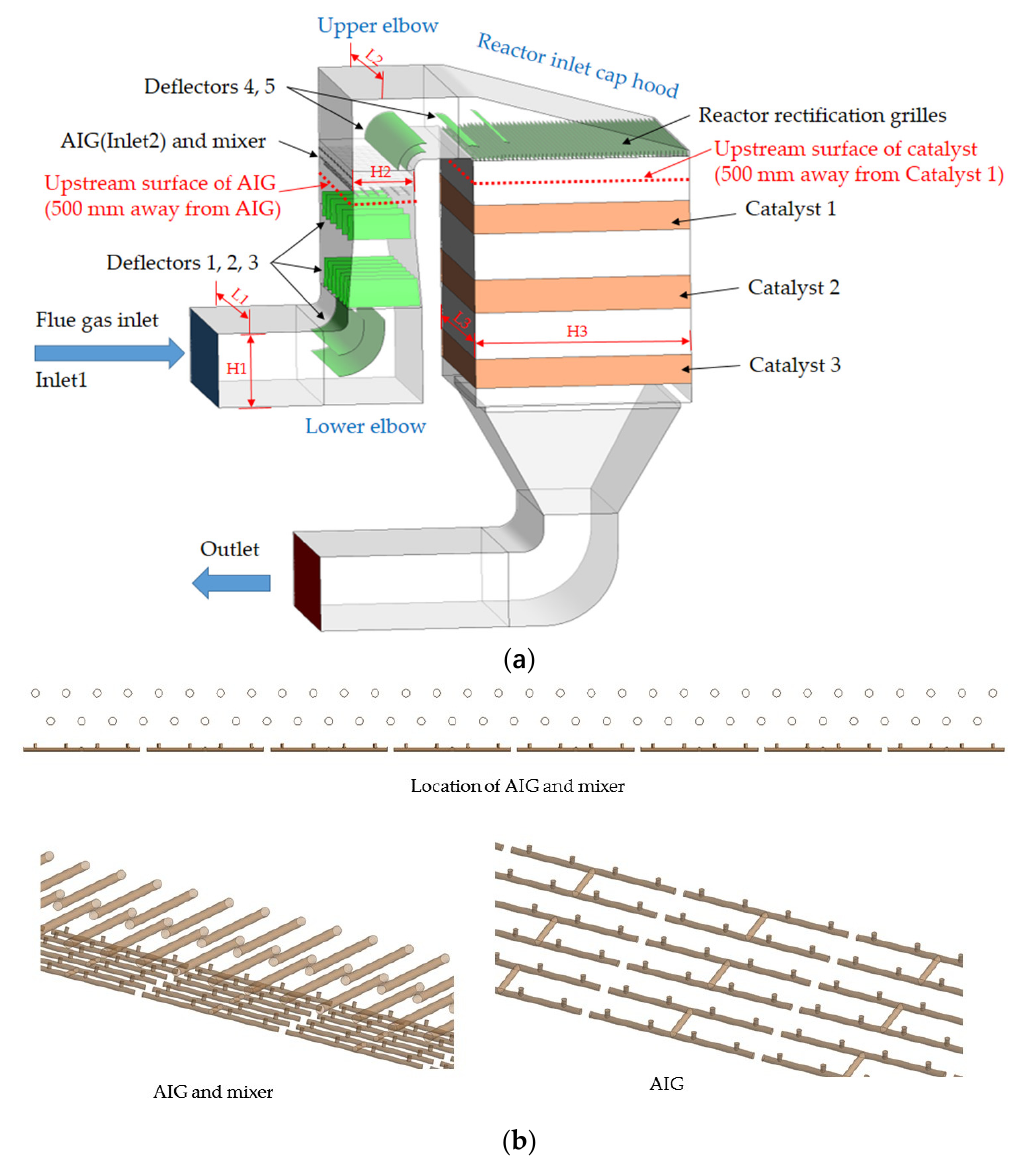
Figure 1. Schematic of the current SCR − DeNOx system: ( a ) overall schematic; ( b ) details of the AIG and mixer.